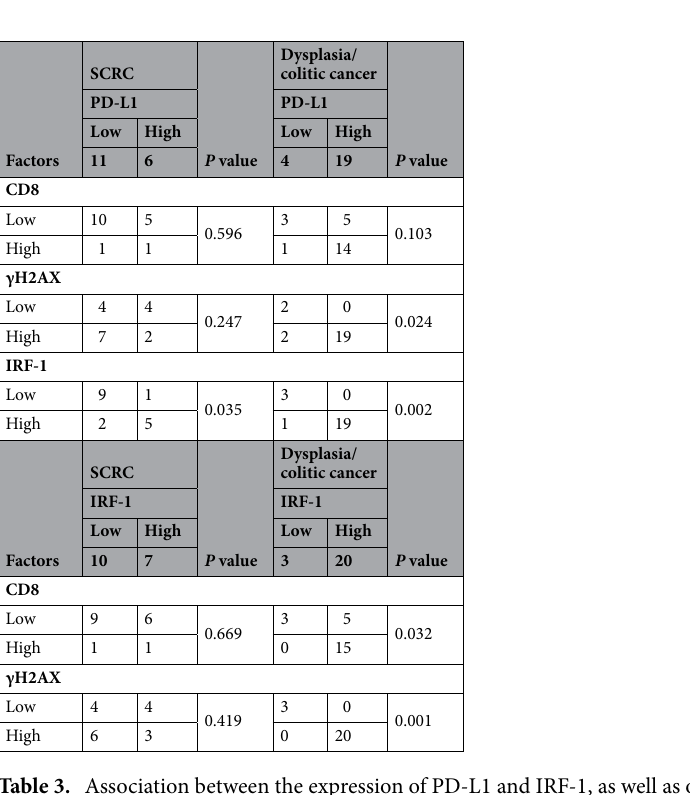
Table 3. Association between the expression of PD-L1 and IRF-1, as well as other proteins, in sporadic colorectal cancer (SCRC) and dysplasia/colitic cancer